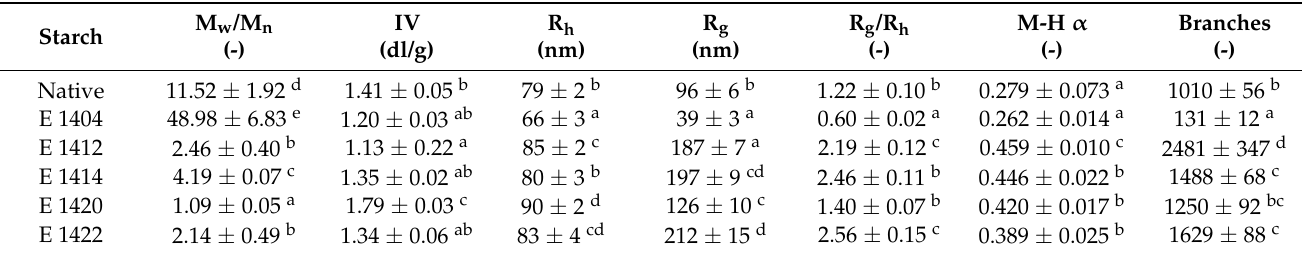
Figure 2. Molecular weight distribution of chemically modified potato starches. Table 4. Hydrodynamic parameters of modified starch preparations.